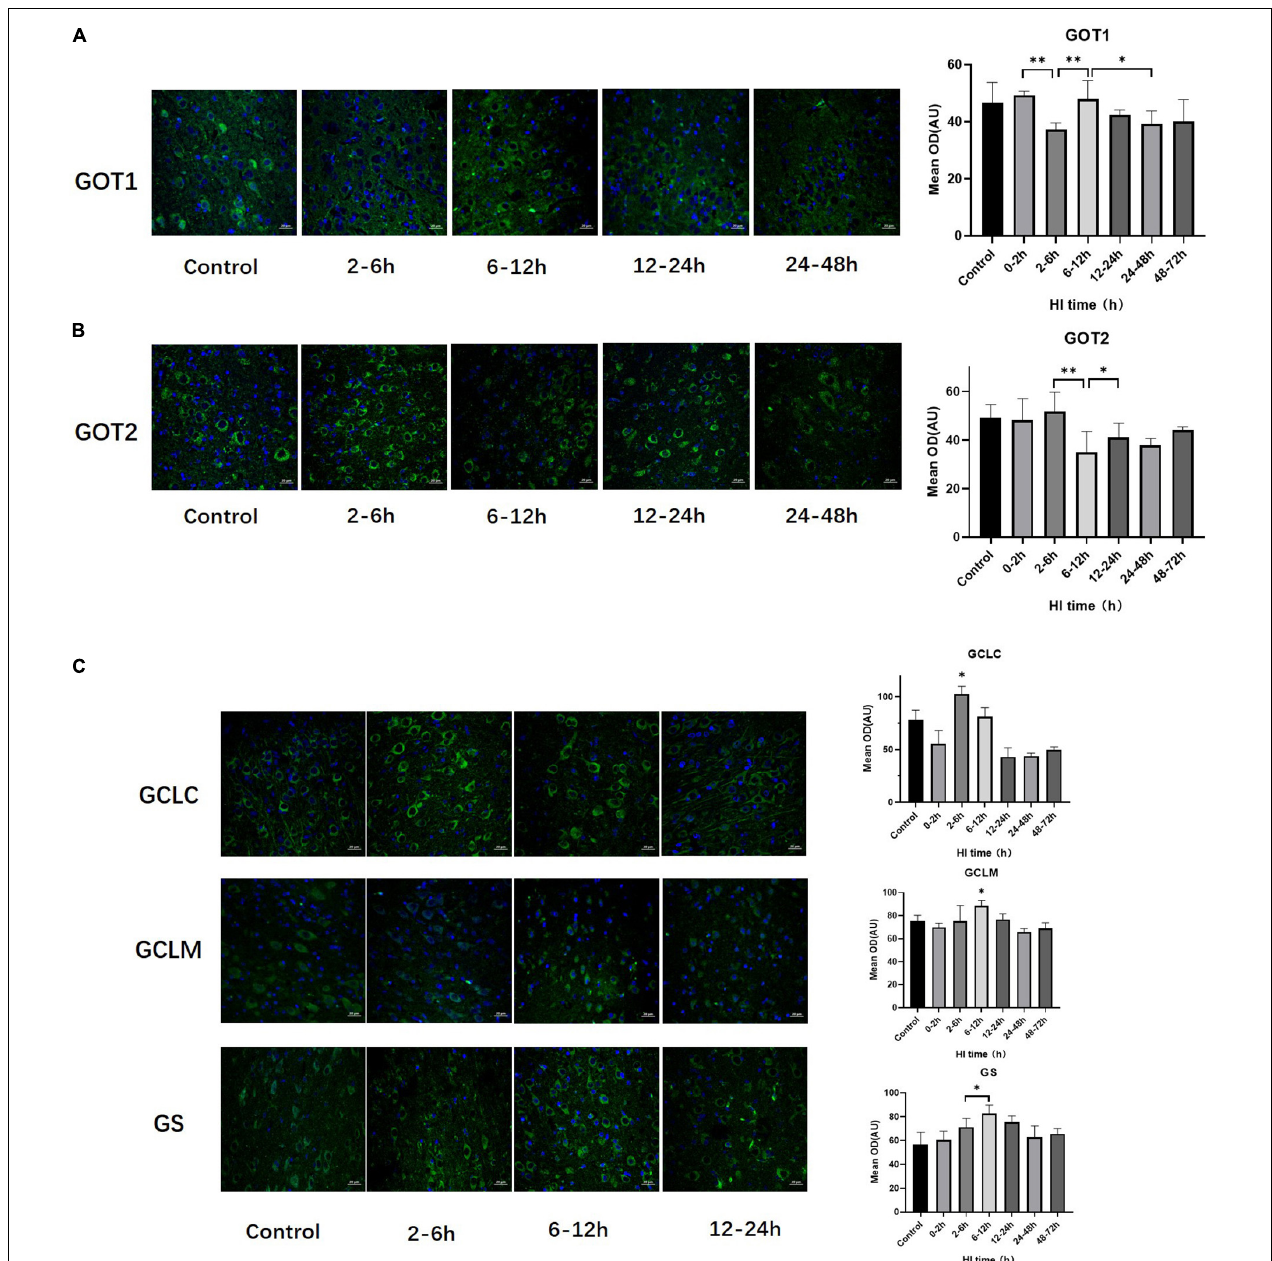
FIGURE 3 | Changes in the expression of GOT1, GOT2, GCLC, GCLM, and GS after HI injury ( × 400). (A) Tendency chart for cerebral GOT1 staining and mean optical density in the control group and HI groups at 2–6, 6–12, 12–24, and 24–48 h after HI. Green fluorescence represents GOT1. The fluorescence intensity of GOT1 decreases at 2–6 h, then increases at 6–12 h, and significantly decreases again at 24–48 h after HI. (B) Tendency chart for cerebral GOT2 staining and mean optical density in the control group and HI groups at 2–6, 6–12, 12–24, and 24–48 h after HI. Green fluorescence represents GOT2. The fluorescence intensity of GOT2 decreases at 6–12 h and then increases at 12–24 h after HI. (C) Tendency chart for the cerebral GCLC, GCLM, and GS staining, and mean optical density in the control group and the groups at 2–6, 6–12, and 12–24 h after HI. Green fluorescence represents GCLC, GCLM, and GS. The fluorescence intensity of GCLC, GCLM, and GS peaks at 2–6 h and 6–12 h after HI. ∗∗ P < 0.01, ∗ P < 0.05; data are expressed as mean ±